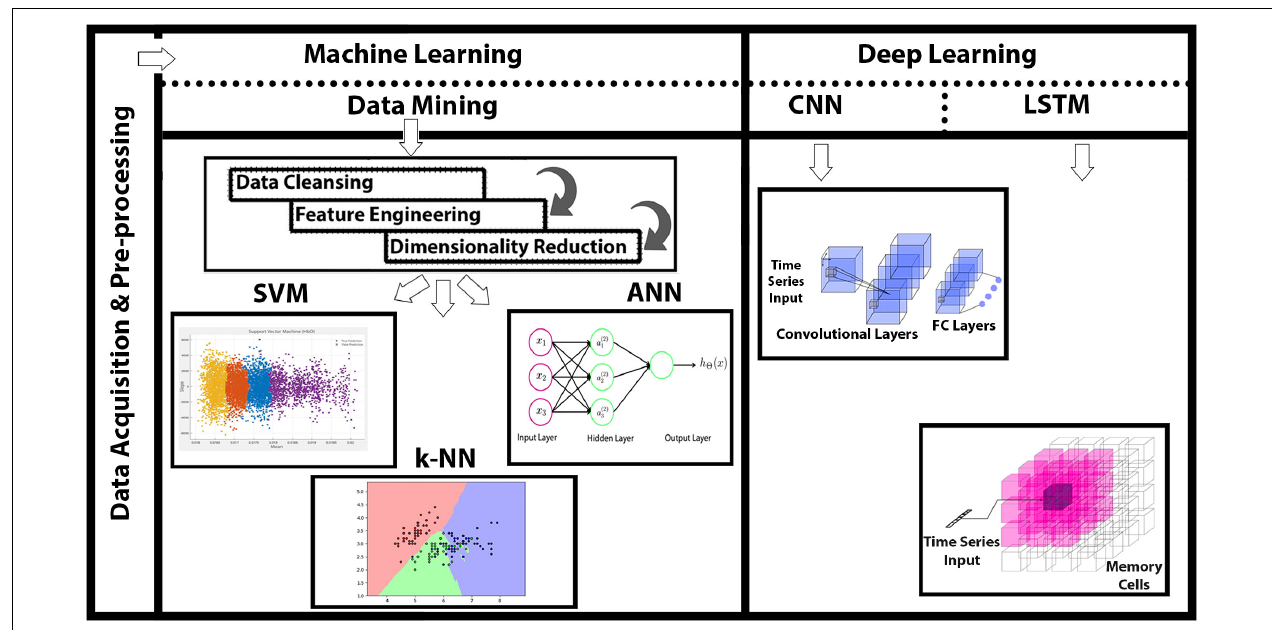
FIGURE 1 | Functional near-infrared spectroscopy (fNIRS)-based mental workload (MWL) classification using machine learning (ML) and deep learning (DL) algorithms. Data acquisition through fNIRS system (P-fNIRSSyst), data preprocessing, and detailed feature engineering followed with application of ML and DL